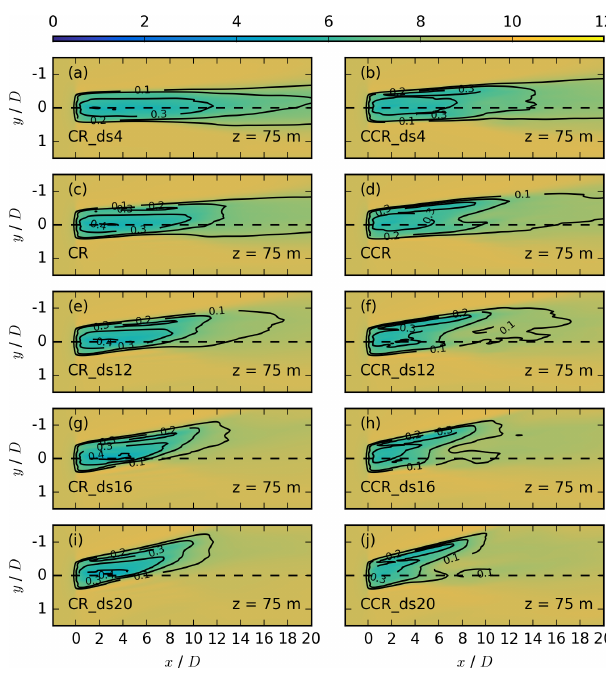
in meters Figure 12. Contours of the streamwise velocity u i,j,k ∗ per second for different directional shears at z = 75m for the same simulations as in Fig. 10. The black contours represent the velocity deficit VD i,j,k at the same vertical location. ∗ Figure 13. Vertical profiles (first column) and horizontal pro- files at z = 75m (second column), z = 100m (third column), and z = 125m (fourth column) of the 30min averaged streamwise ve- locity at x = 7D downwind of the actuator for a directional shear of 0.04 ◦ m − 1 in (a–d) , 0.08 ◦ m − 1 in (e–h) , 0.12 ◦ m − 1 in (i–l) , 0.16 ◦ m − 1 in (m–p) , and 0.20 ◦ m − 1 in (q–t)